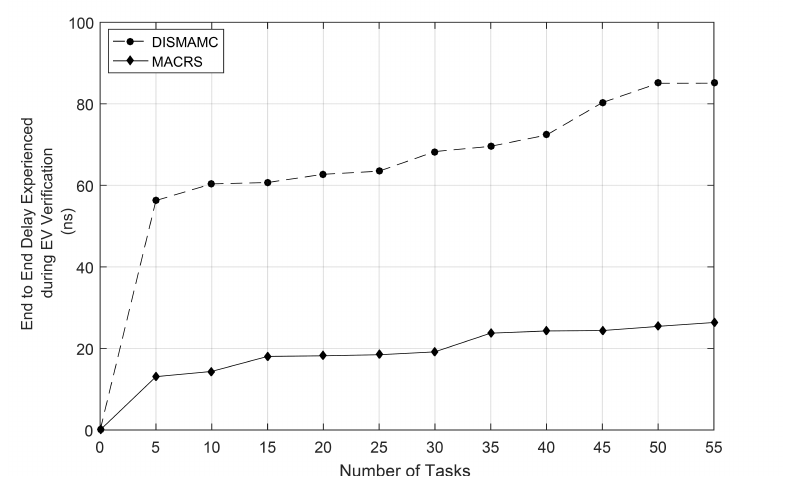
Figure 16. End-to-end delay experienced during EV verification.